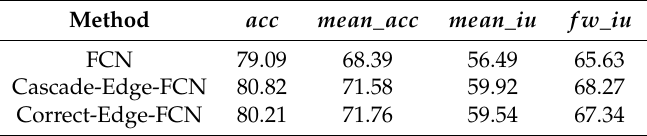
Table 6. Evaluation Results Of large image on ESAR.